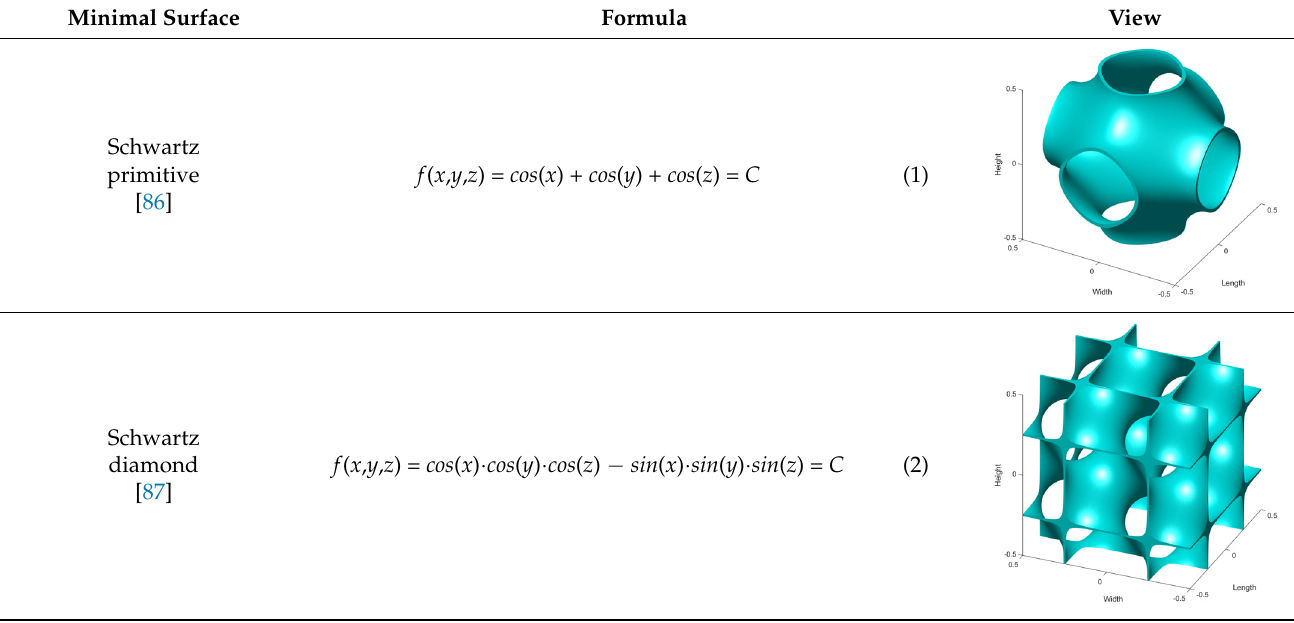
Table 1. Examples of minimal surfaces (name, surface view, and mathematical notation).